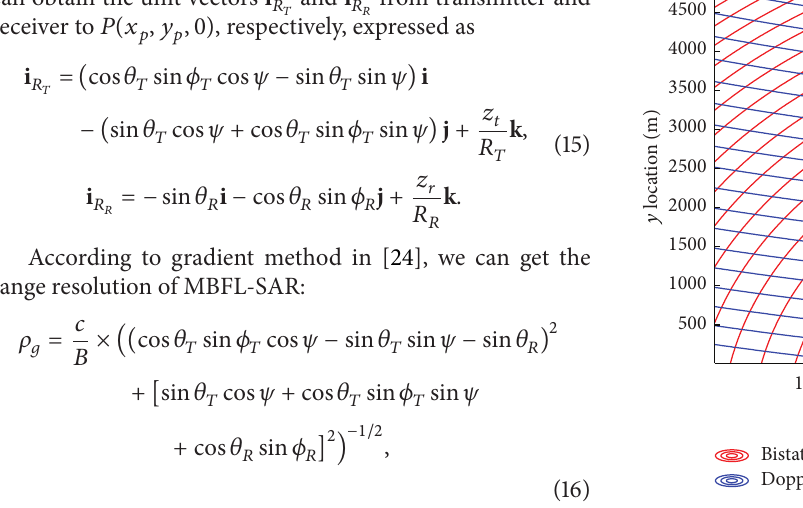
Figure 3: MBFL-SAR range contours and Doppler frequency con- tours when 𝑡 𝑚 = 0